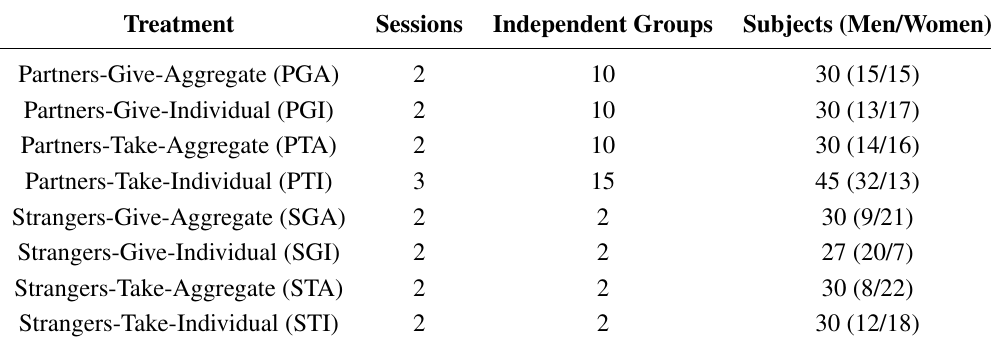
Table 3. Design information for